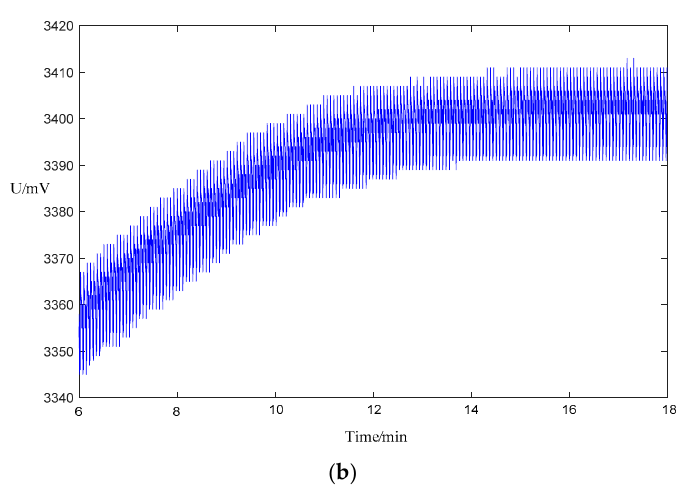
Figure 14. Distribution of the cell voltage ( a ) without equalization; and ( b ) with equalisation.